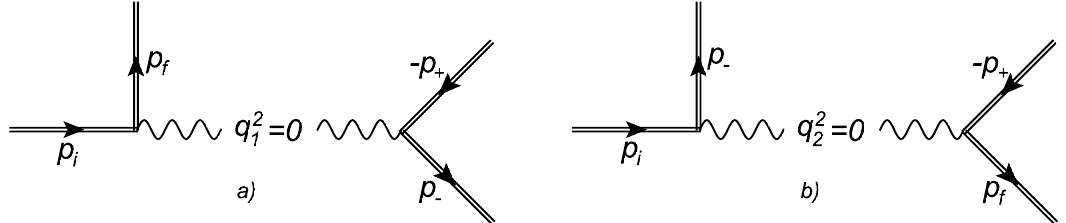
Figure 1. Feynman diagrams of resonant electron-positron pair production by an electron in the field of the X-ray pulsar. ( a )—channel “a”; ( b )—channel “b”. Double lines correspond to Volkov